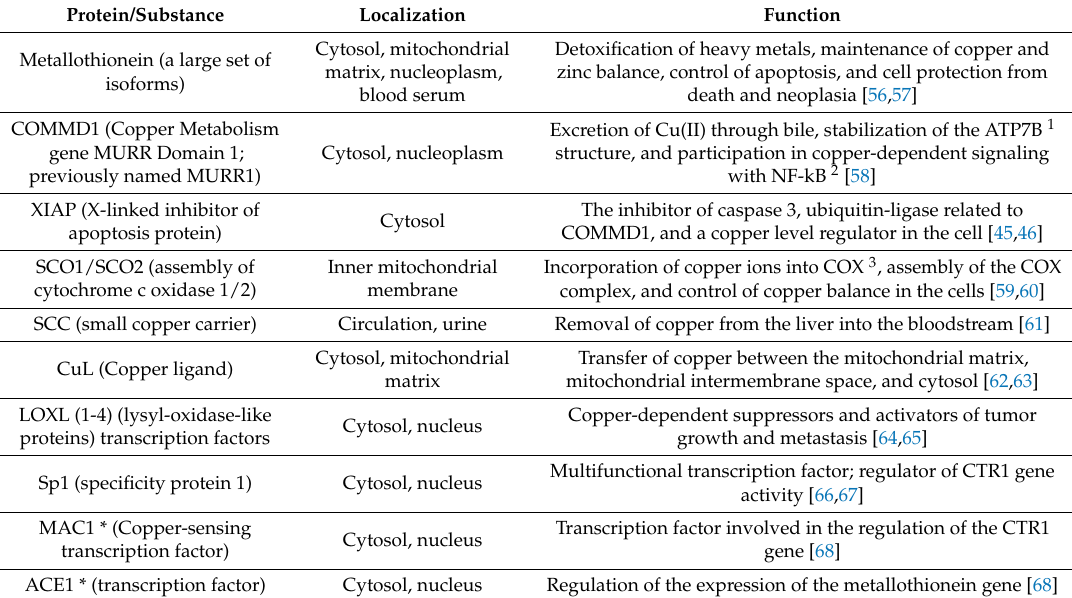
Table 2. Mammalian proteins and substances for controlling copper homeodynamics or participating in copper-dependent